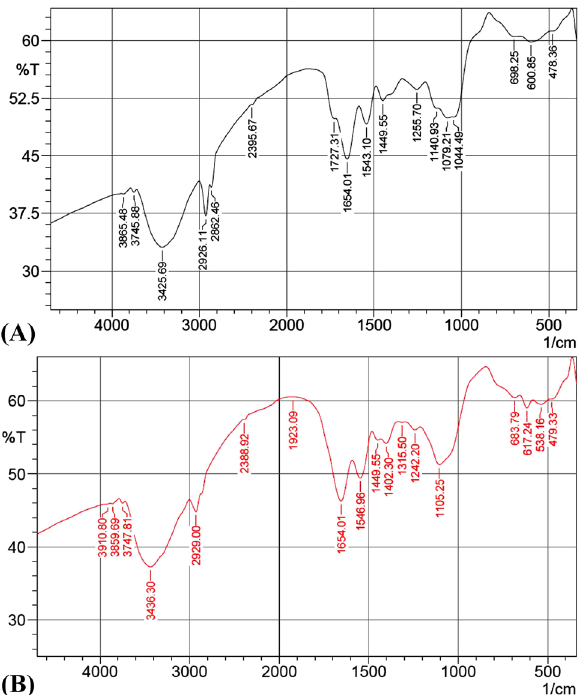
Figure 7. FTIR analysis of Scenedesmus obliquus biomass: ( A ) before and ( B ) after methyl red